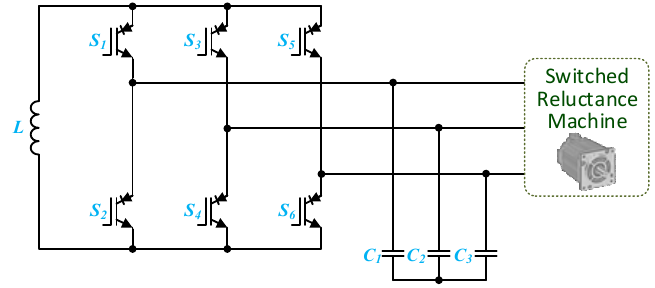
Figure 22. Current source power converter for the control of three-phase ac electric machines.